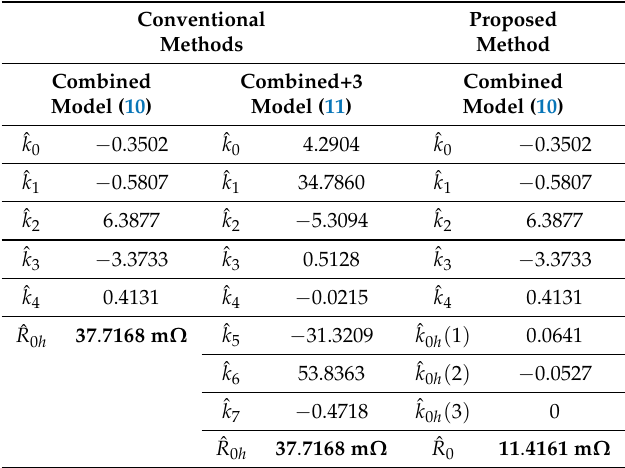
Table 2. Estimated parameters: